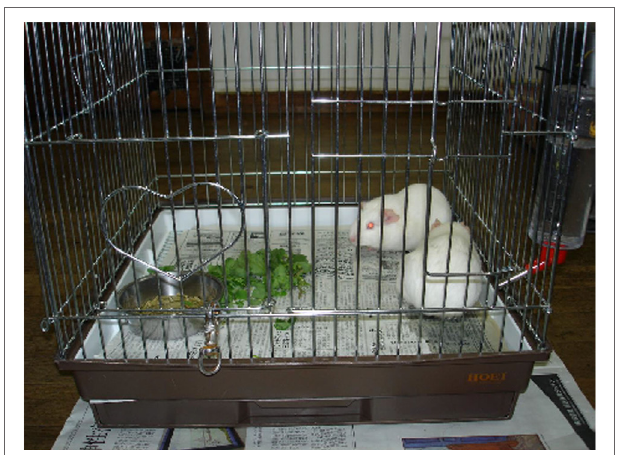
FiGURe 3 | Animals in a cage in the classroom.